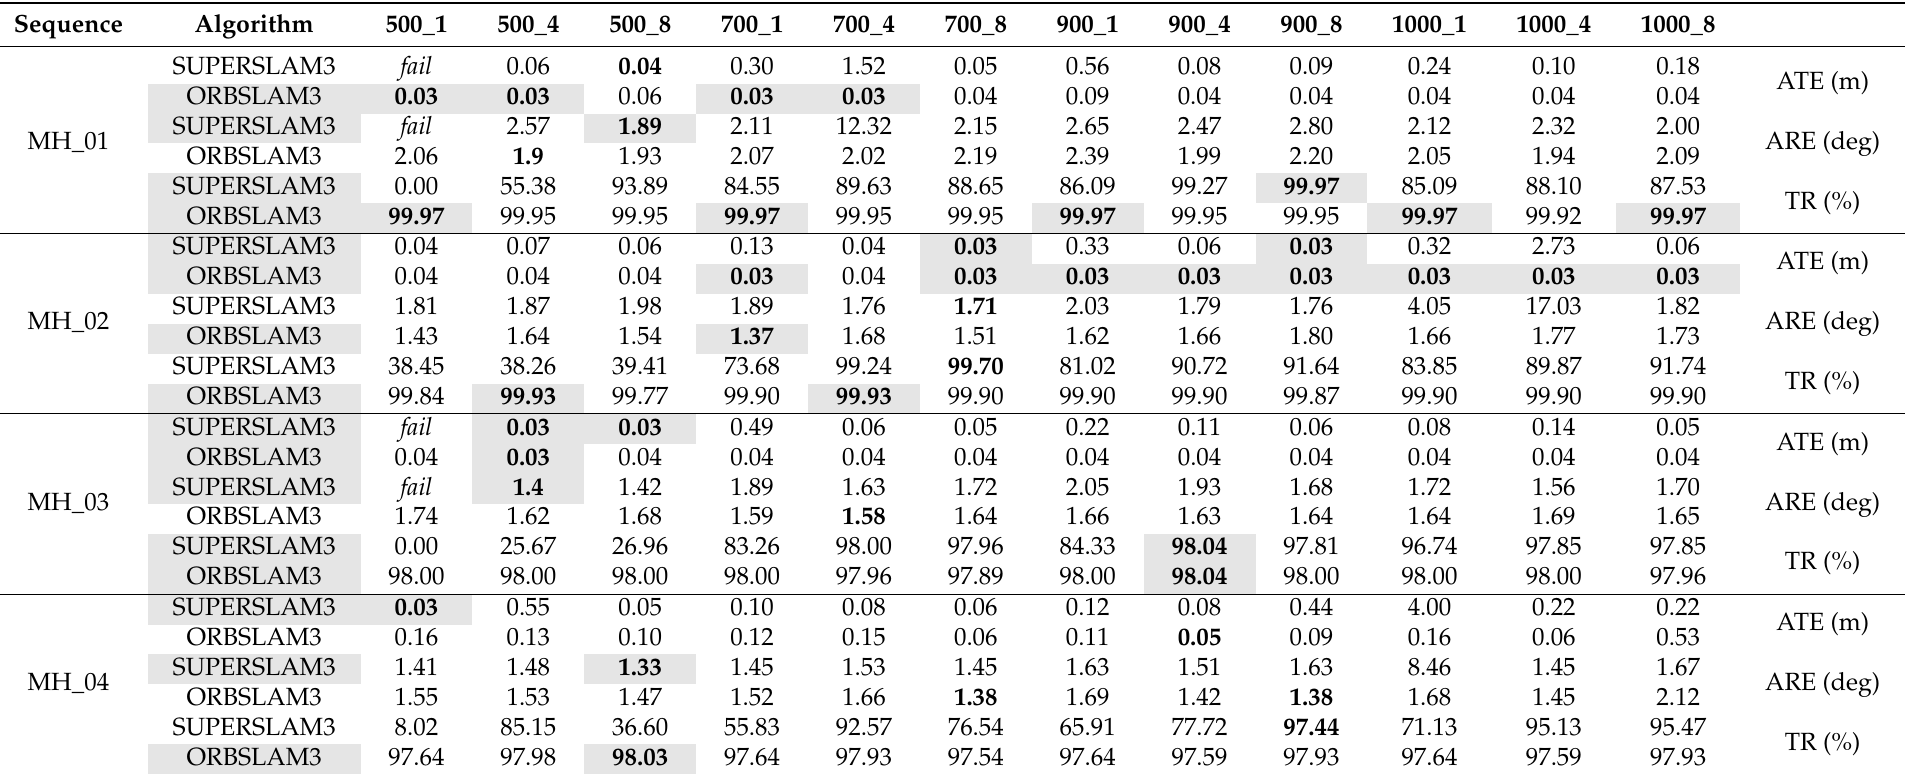
Table 1. Quantitative results on EuRoC. For each sequence and for each performance metric, we highlight in bold the parameter configuration that attained the best result (for both ORBSLAM3 and SUPERSLAM3) individually for each analyzed metric (as described in the table’s right header). To indicate the one with the highest performance between the two, we color the corresponding cell and highlight the algorithm name in gray. In the table’s top header the parameters set are represented in the form ‘ nFeatures_nLevels